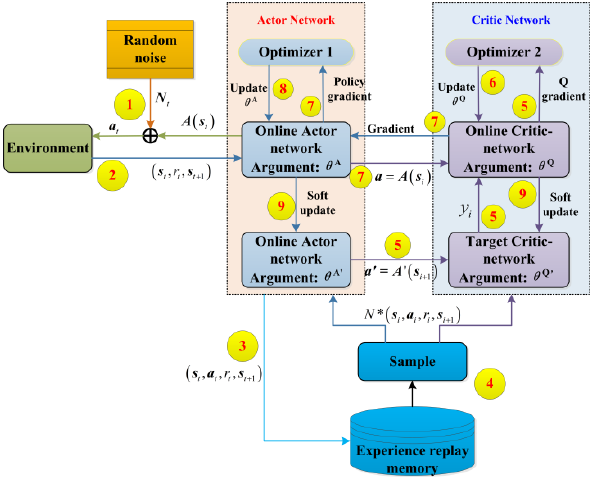
Figure 3. The actor and critic architecture of DDPG.